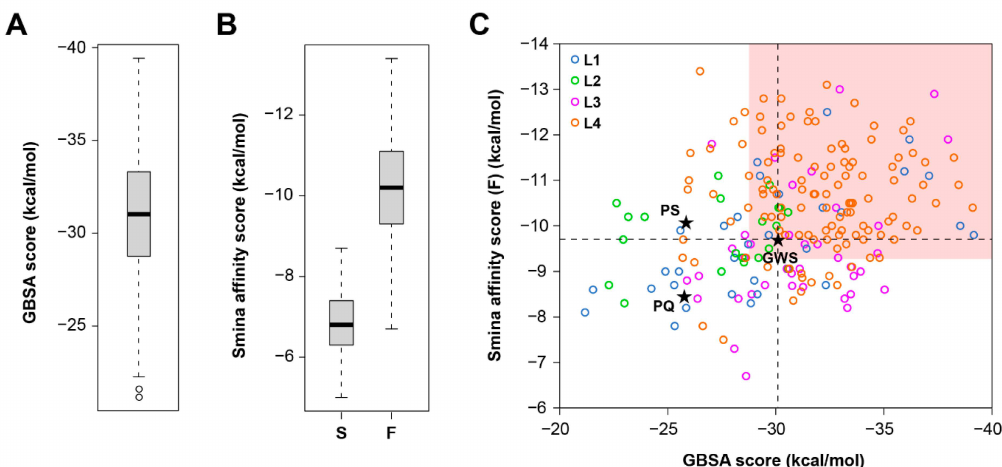
Figure 2. Values of docking energy estimates obtained for the target compounds. ( A ) Box-and-whisker plot for the DOCK energy scores. ( B ) Box-and-whisker plots for the Smina affinity scores obtained with standard (S) rigid receptor docking and the flexible receptor (F) approach. ( C ) Distribution of values among the four libraries of compounds evaluated (L1, L2, L3 and L4), with compounds meeting the selection criteria clustering in the area highlighted in pink. Energy scores obtained for the co-crystalized ligand (GWS) are indicated with dashed lines. PQ: 2-propylquinoline, PS: